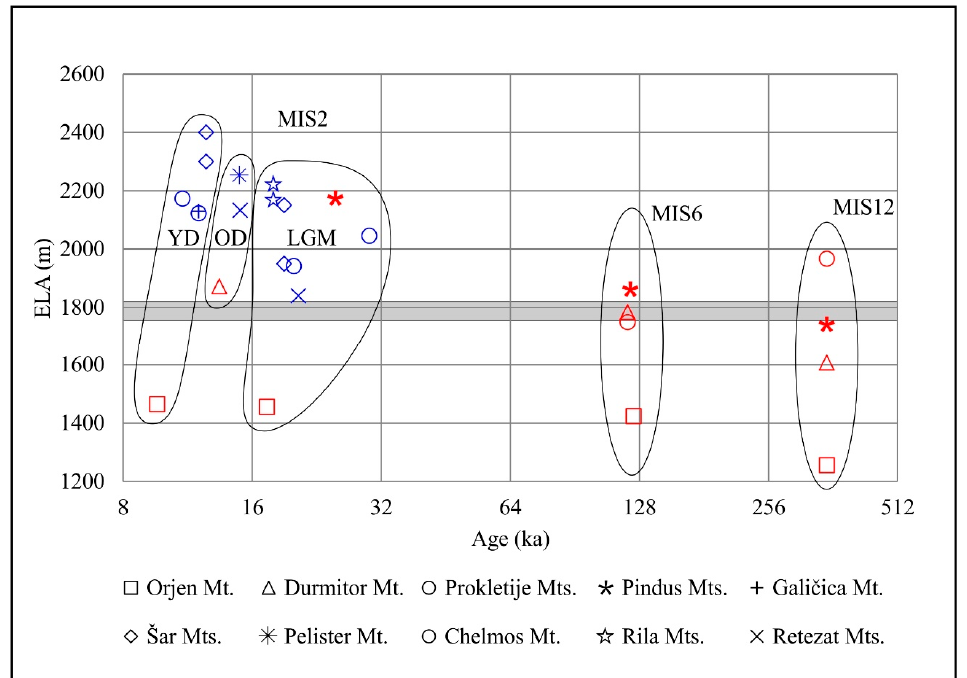
Figure 10. Elevations of ELAs and their assigned ages from mountain ranges in the region and the range of rMIE ELA values from Jablanica Mt. (shaded area). Red symbols represent minimum ages. Age scale is logarithmic. For location of discussed mountains refer to Figure 1. Sources: Orjen Mt. [10]; Durmitor Mts. [11]; Prokletije Mts. [57]; Pindus Mts. [54]; Gali č ica Mt. [19]; Šar Mts. [14]; Pelister Mt. [16]; Chelmos Mt. [18]; Rila Mts. [15]; Retezat Mts. [58].